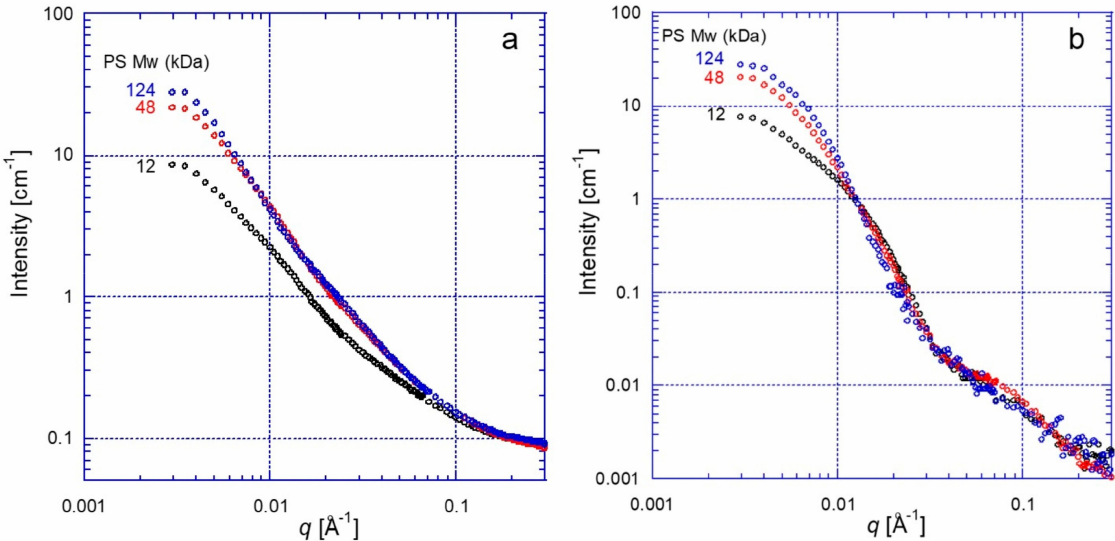
Figure 8. SANS patterns of 0.5 wt.% MWCNT + 1 wt.% S4VP dispersions with block copolymers of different PS block MWs (S 12 -b-4VP 12 , S 48 -b-4VP 11 , S 124 -b-4VP 12 ) in DMF solvent containing 100% DMF-d7 (CNT matched), before ( a ) and after ( b ) background